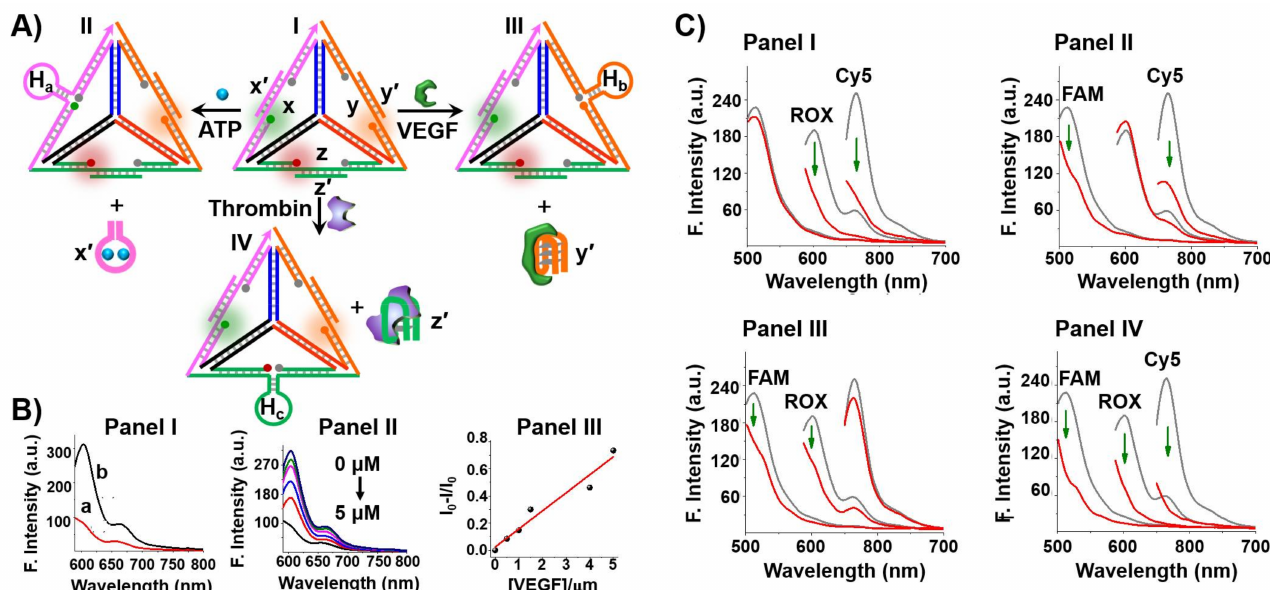
Figure 4. ( A ) Multiplex analysis of three different ligands (ATP, VEGF and thrombin) using a functional DNA tetrahedron module (I) functionalized at the three edges with ATP aptamer (x’), VEGF aptamer (y’) and thrombin aptamer (z’). The aptamer units stretch the fluorophore-quencher functionalized edges (x, y, z) into fluorescent configurations (x-FAM, y-ROX, z-Cy5). The formation of the respective aptamer-ligand complexes led to the displacement of the x’-ATP, y’-VEGF and z’-thrombin complexes and to the distortion of the respective edges into fluorophore-quenched configuration allowing the multiplex analysis of the respective ligands and their quantitative sensing. ( B ) Example for the fluorescence analysis of VEGF through the distortion of edge y’ and quenching of ROX. Panel I—fluorescence of ROX in the DNA tetrahedron module: a. before addition of VEGF; b. after addition of VEGF, 5 µ M. Panel II—fluorescence of ROX in the DNA tetrahedron module upon sensing of different concentrations of VEGF for a fixed interval of time. Panel III—derived calibration curve for sensing VEGF with the DNA tetrahedra module. ( C ) Multiplex analysis of the different ligands by the DNA tetrahedron module. Fluorescence changes upon sensing: Panel I—VEGF and thrombin; Panel II—ATP and VEGF; Panel III—ATP and thrombin; Panel IV—ATP, VEGF, and thrombin. Arrows represent the decrease in the fluorescence. Reproduced with permission from ref. [102]. Copyright 2020 American Chemical